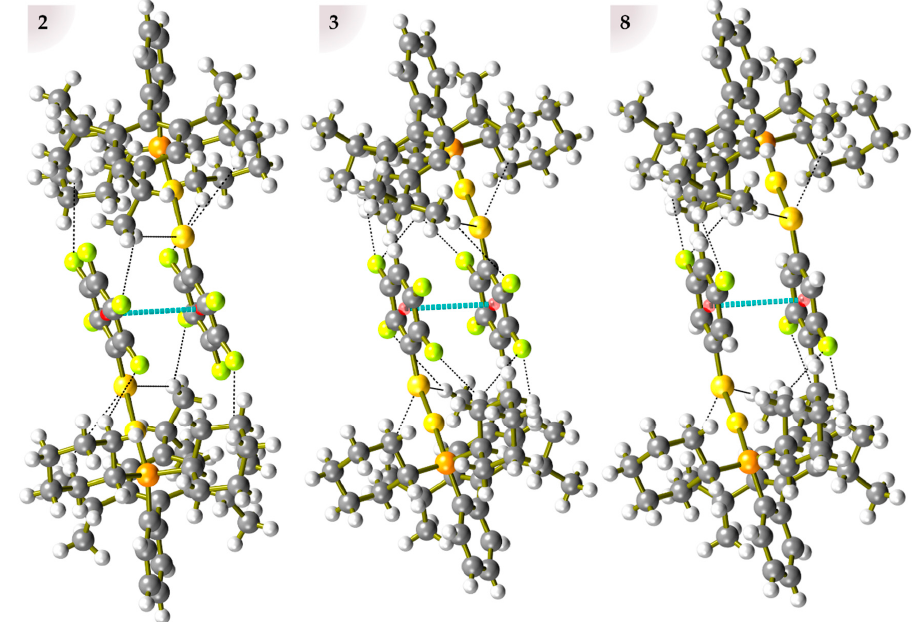
Figure 5. Dimeric associations of compounds 2 , 3 , and 8 displaying π F · · · π F stacking interactions. C 6 centroids are shown in red; the centroid-to-centroid distances (blue trace) are 3.634, 3.490, and 3.528 Å. The stacking interactions show interplanar distances of 3.419, 3.346, and 3.421 Å, respectively, for 2 , 3 , and 8 .